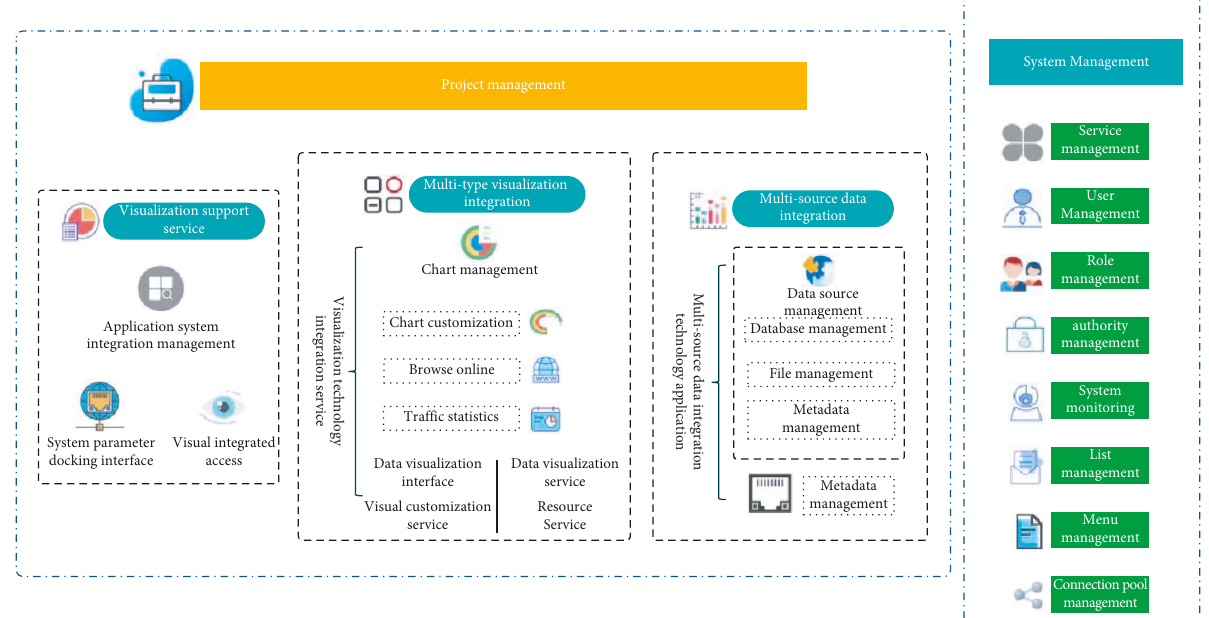
Figure 1: Visual communication combined with